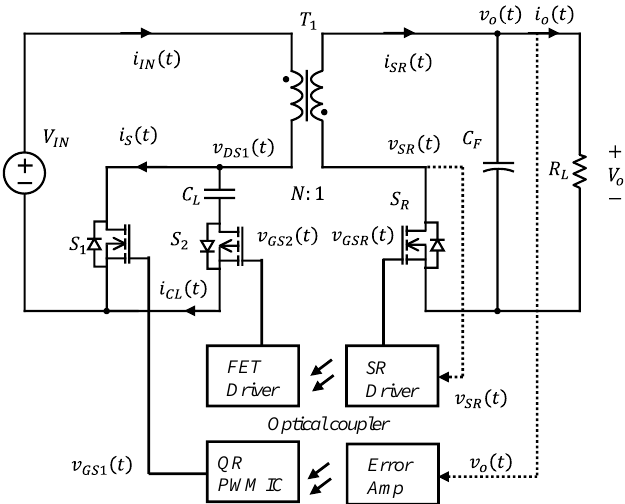
Figure 16. Basic circuit and control structure of QR flyback converter with SDAS.